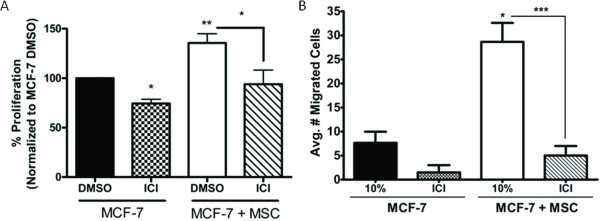
Inhibition of ER signaling decreases hMSC stimulated MCF-7 proliferation and migration in vitro. (A) MCF-7 cells were seeded in the lower chamber of a 24-well plate with MCF-7 cells or hMSCs were seeded in the upper well. Upper and lower chambers were treated with either DMSO (control) or ICI (100 nM). After 7 days of culture, inserts were removed and MTT was added to each well. Cells were solubilized and absorbance read. All data are represented as normalized percent proliferation compared to MCF-7 + DMSO (control) treated cells ± SEM, (* p < 0.05, ** p < 0.01). (B) MCF-7-GFP cells alone or in combination with hMSCs (1:1) were seeded in the upper chamber of a transwell system and lower wells contained culture media supplemented with 10% FBS (10%). Upper and lower chambers were treated with either DMSO (control) or ICI (100 nM). After 48 hours cells were fixed and the number of GFP positive migrated cells counted. Bars represent average number of migrated cell per condition ± SEM, (* p < 0.05, *** p < 0.001).